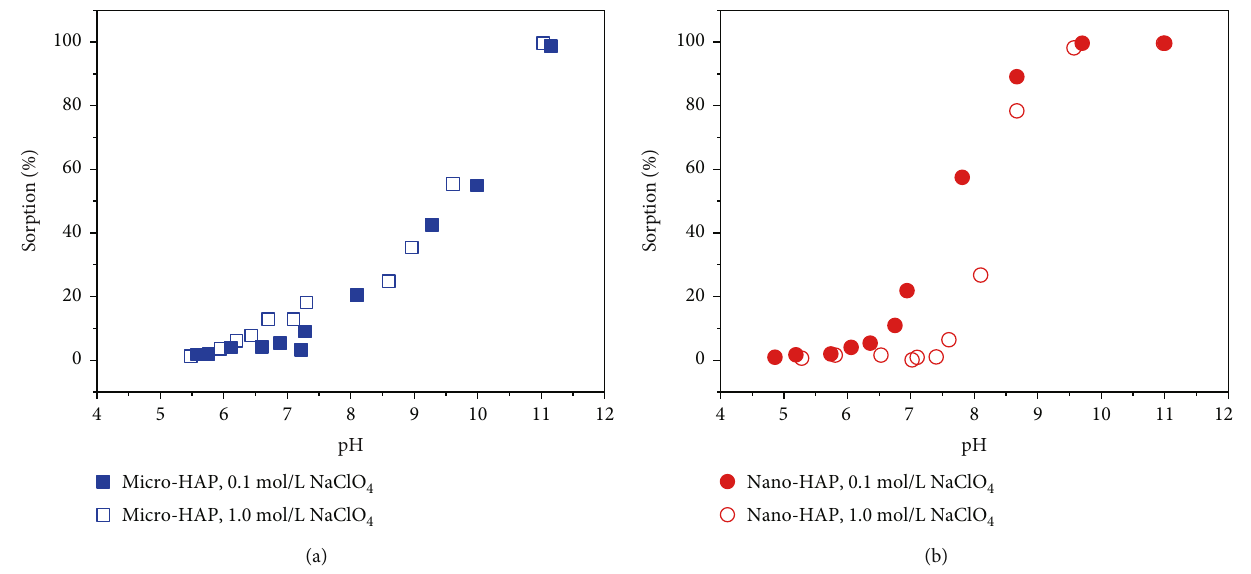
Figure 5: The in fl uence of ionic strength on Ni(II) sorption on (a) micro-HAP and (b) nano-HAP ( T = 298 ± 1 K , s / l = 0 : 6 g/L, and ½ Ni ð II Þ = 5 : 0 mg/L )